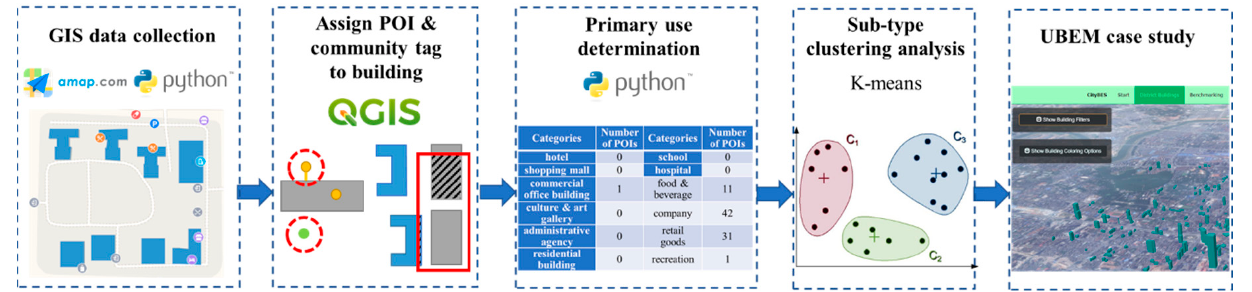
Figure 1. Research workflow. UBEM: Urban building energy modeling; POI: point-of-interest.